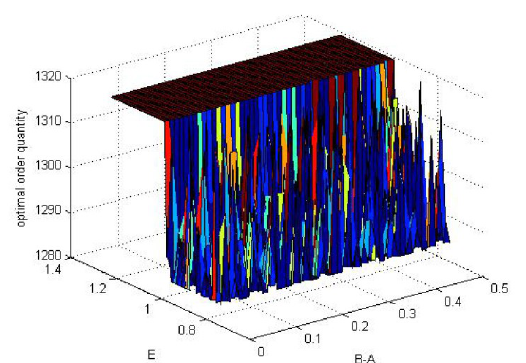
Figure 2. Optimal order quantity with buy-back contract (Settle the buy-back payment in the currency of country